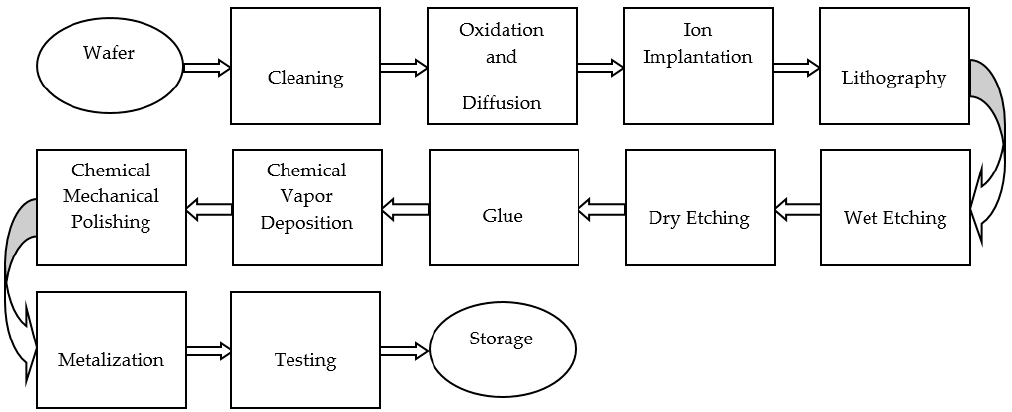
Figure 1. The main technological process of the chip manufacturing company.